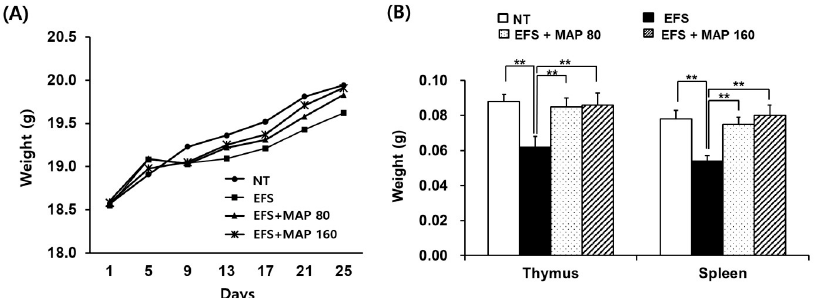
Figure 1. Alleviative effect of modified Aloe polysaccharide (MAP) against chronic electric foot shock (EFS) stress-induced atrophy of immune apparatus and weight loss. NT (No treatment), normal control; EFS only, EFS stress-induced mice; EFS + MAP 80, EFS stress-induced mice treated with a low dose (mg/kg) of MAP 80; EFS + MAP 160, EFS stress-induced mice treated with a high dose (mg/kg) of MAP 160. Average body weight ( A ) was measured every four days until sacrifice. The thymus and spleen were excised and weighed after sacrifice ( B ). Values are means ± SEM of three experiments, n = 20. ** p < 0.01, compared to control levels.